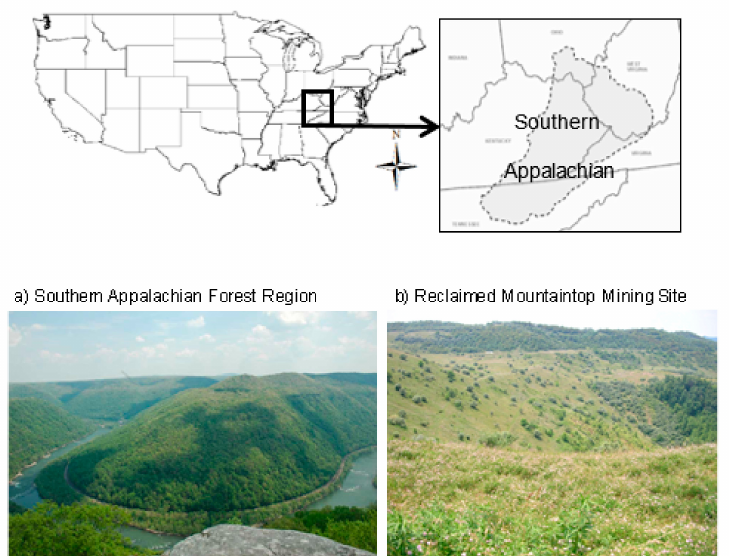
Figure 1. ( a ) Undisturbed forests and ( b ) grassland remaining after reclamation. The surface mining occurring in the Southern Appalachian Forests Region (SAFR) was most recently estimated as removing 590,000 ha of the land surface [9]. Of this, almost all of the land after SMCRA (1977) was reclaimed as grassland. The number of grassland-reclaimed mines that are converted to forests has increased substantially in the past decade. Wickham et al. [2] reported that only 370 ha of the region was re-reclaimed as forests in 2011. Since that time, the Appalachian Regional Reforestation Initiative has reportedly planted 187 million trees over 110,000 ha in the region [12]. Currently, 304,000 ha of grassland-reclaimed mine sites are post-bond released and unused, and could be available for reforestation (Appalachian Regional Reforestation Initiative, ARRI)